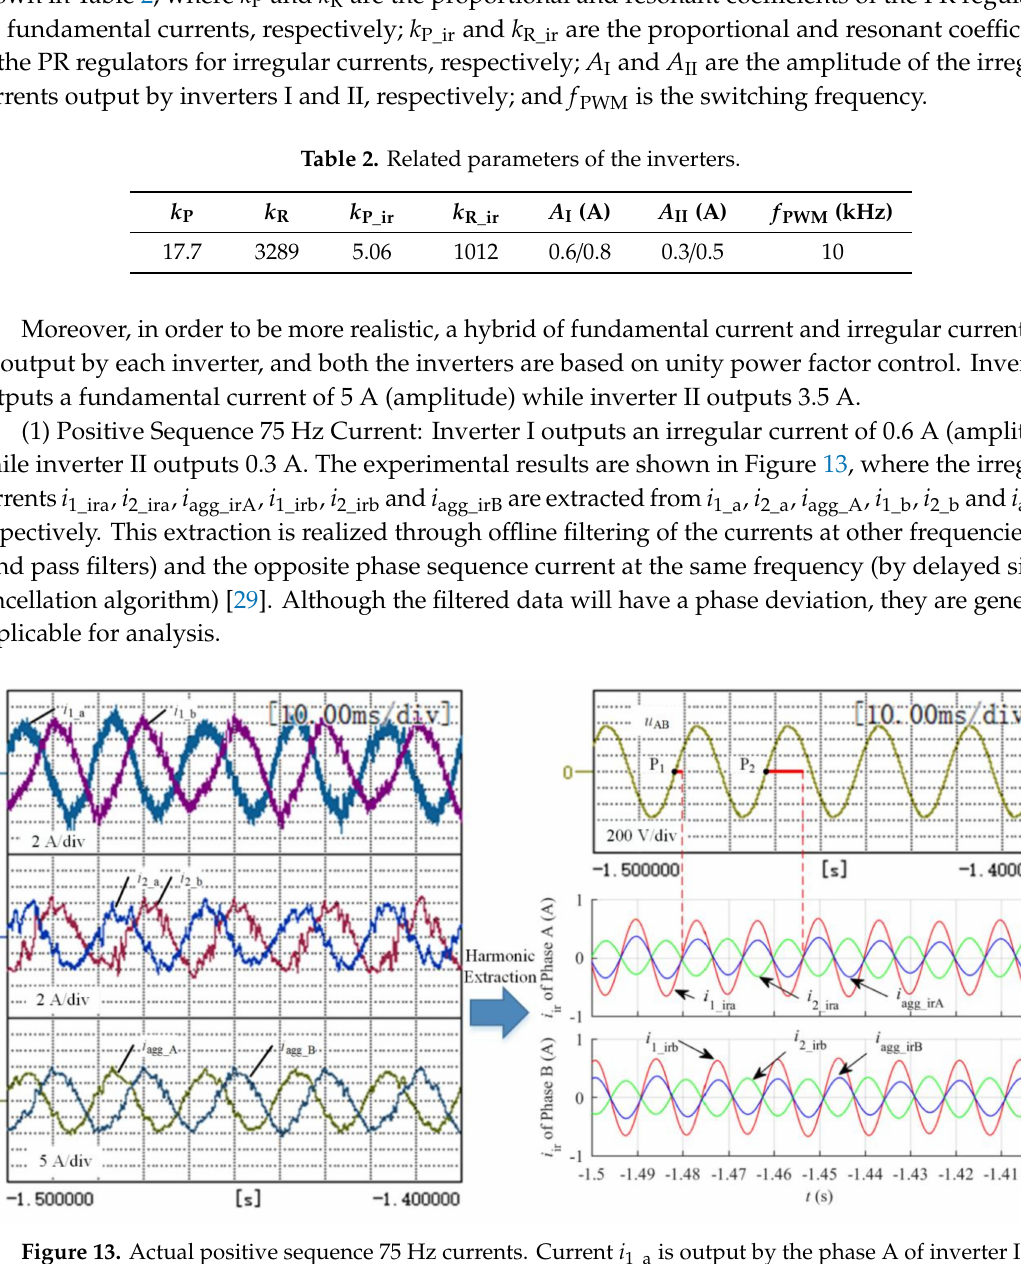
Figure 13. Actual positive sequence 75 Hz currents. Current i 1_a is output by the phase A of inverter I while i 1_ira is the irregular current therein, and the others can be